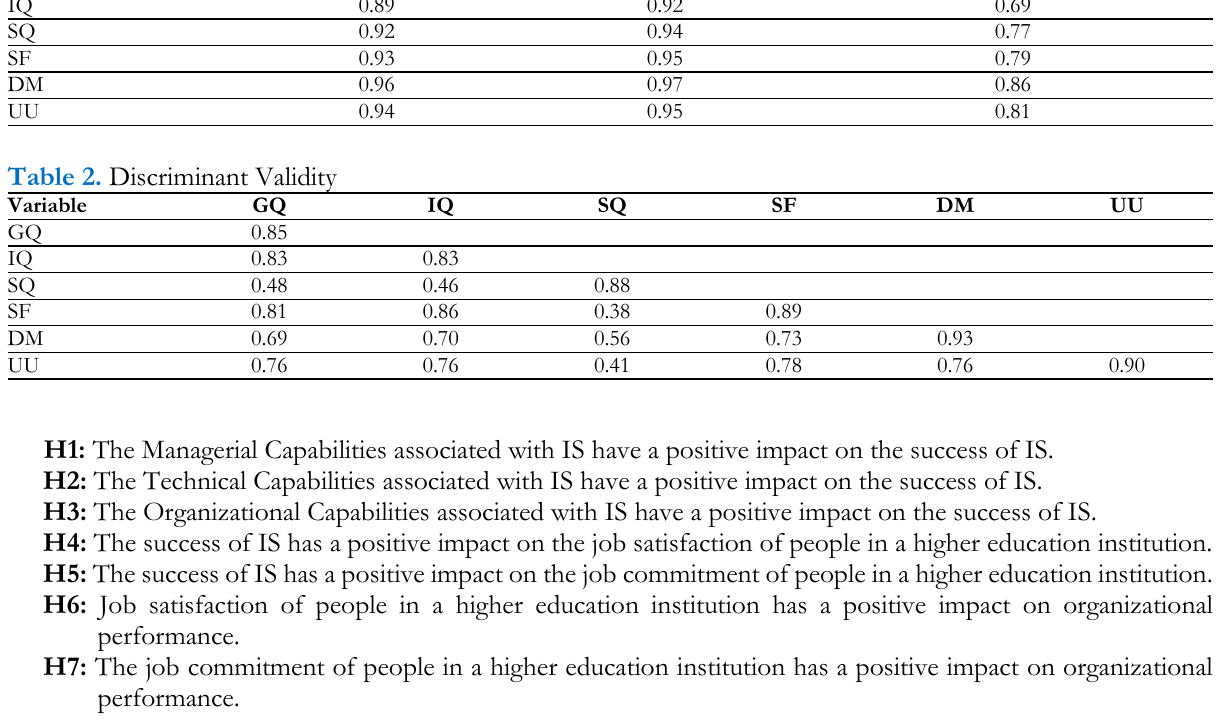
Table 1. Reliability and Validity Indices Variable